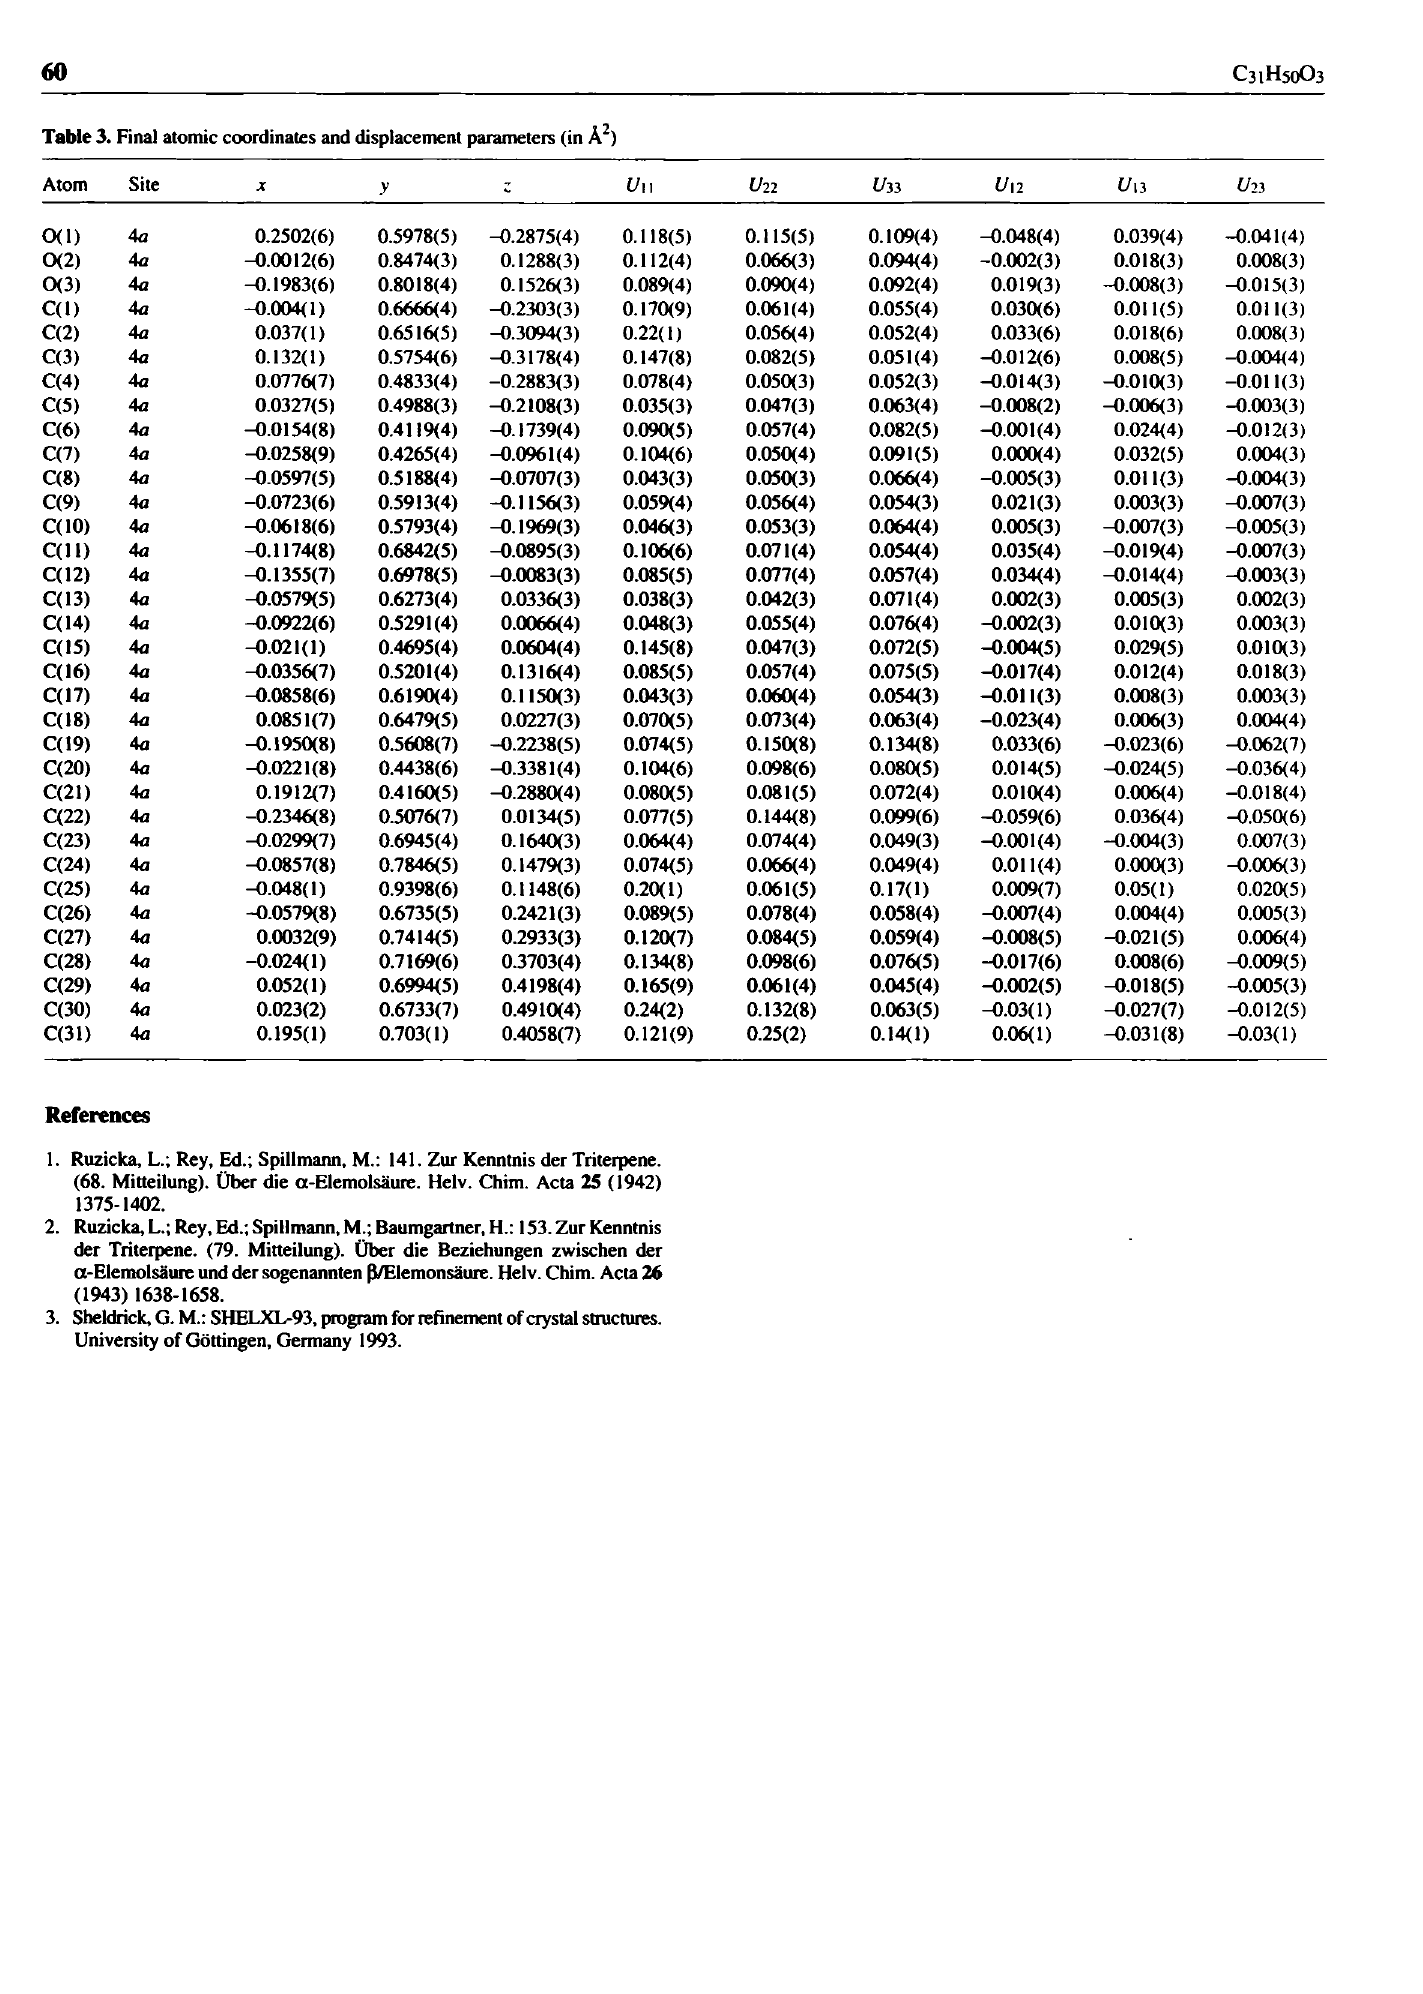
Table 3. Final atomic coordinates and displacement parameters (in Ä 2